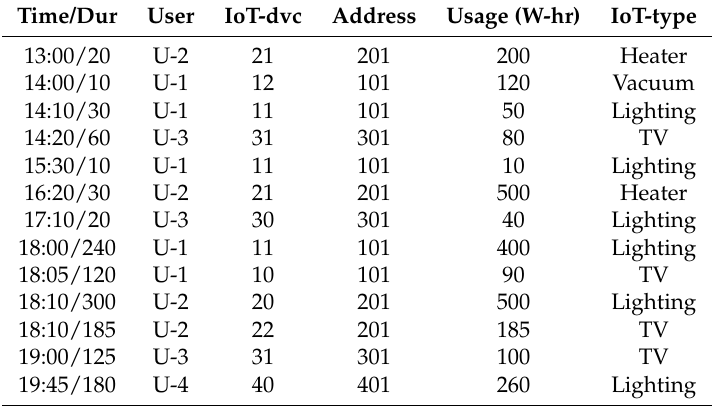
Table 1. Power consumption data in credit-sharing group